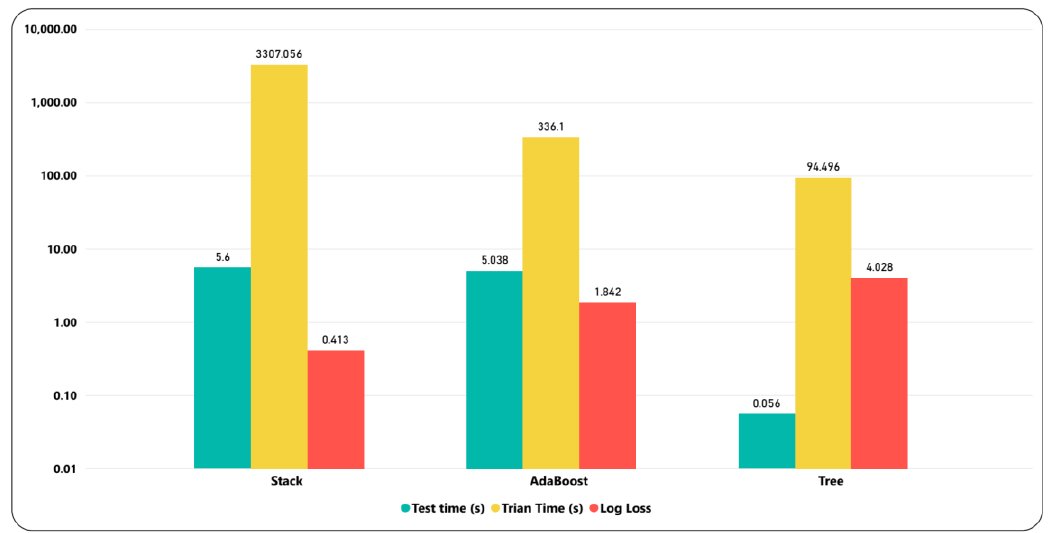
Figure 6. Accuracy, specificity, and F-1 score comparison for different models .